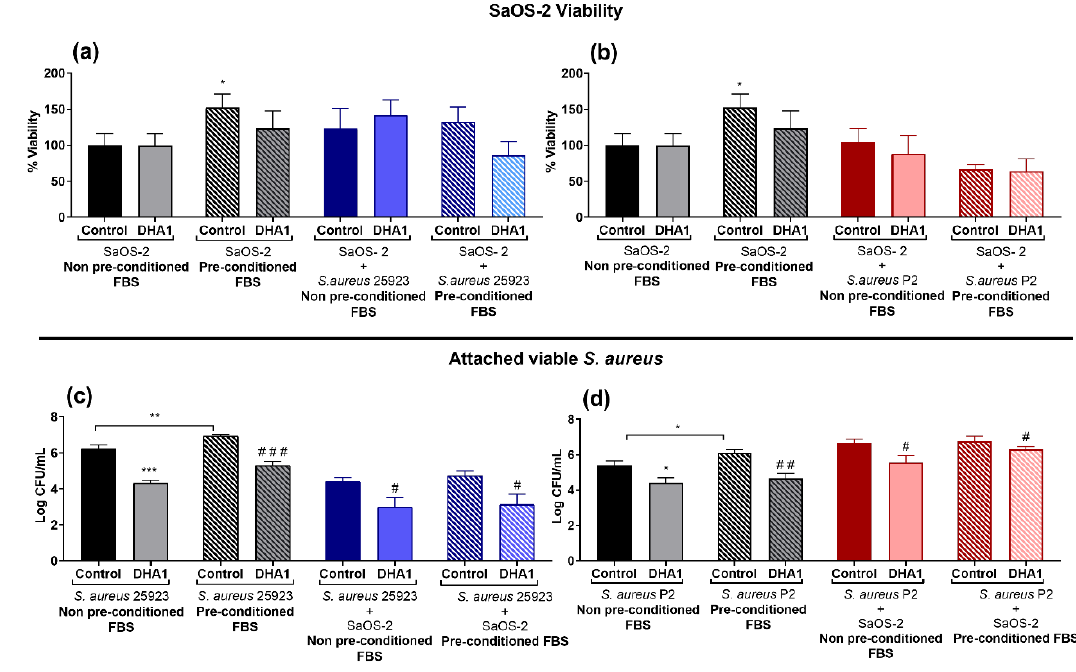
Figure 8. E ff ect of the DHA derivative DHA1 on the competitive colonization assay performed in titanium coupons pre-conditioned with media supplemented with FBS. ( a , b ) Results corresponding to the viability of SaOS-2 cells when ATCC 25923 ( a , blue bars) or P2 clinical S. aureus strain ( b , red bars) were used. ( c , d ) Results corresponding to the e ff ects of attached viable S. aureus measured when ATCC 25923 ( c , blue bars) or P2 clinical strain ( d , red bars) were used. The percentage of viability of SaOS-2 cells was calculated with respect to untreated controls after 24-h incubation on titanium coupons, using glow luminescence signal resulting from ATP production by viable SaOS-2 cells. Viable counts (log of CFU / mL) of S. aureus 25923 and the clinical strain P2, respectively, were also measured after 24-h incubation on titanium coupons when co-cultured with SaOS-2 cells. “*” represents di ff erences with the control in mono-culture exposed to the non-preconditioned titanium coupon (SaOS-2 non- preconditioned with FBS / S. aureus 25923 non-preconditioned / S. aureus P2 non-preconditioned). “#” represents di ff erences with the control of the subgroups (* p < 0.05; ** p < 0.01; *** p < 0.001) / ( # p < 0.05; ## p < 0.01; ### p < 0.001). Results are expressed as mean ± SEM of three technical replicates; experiments repeated three